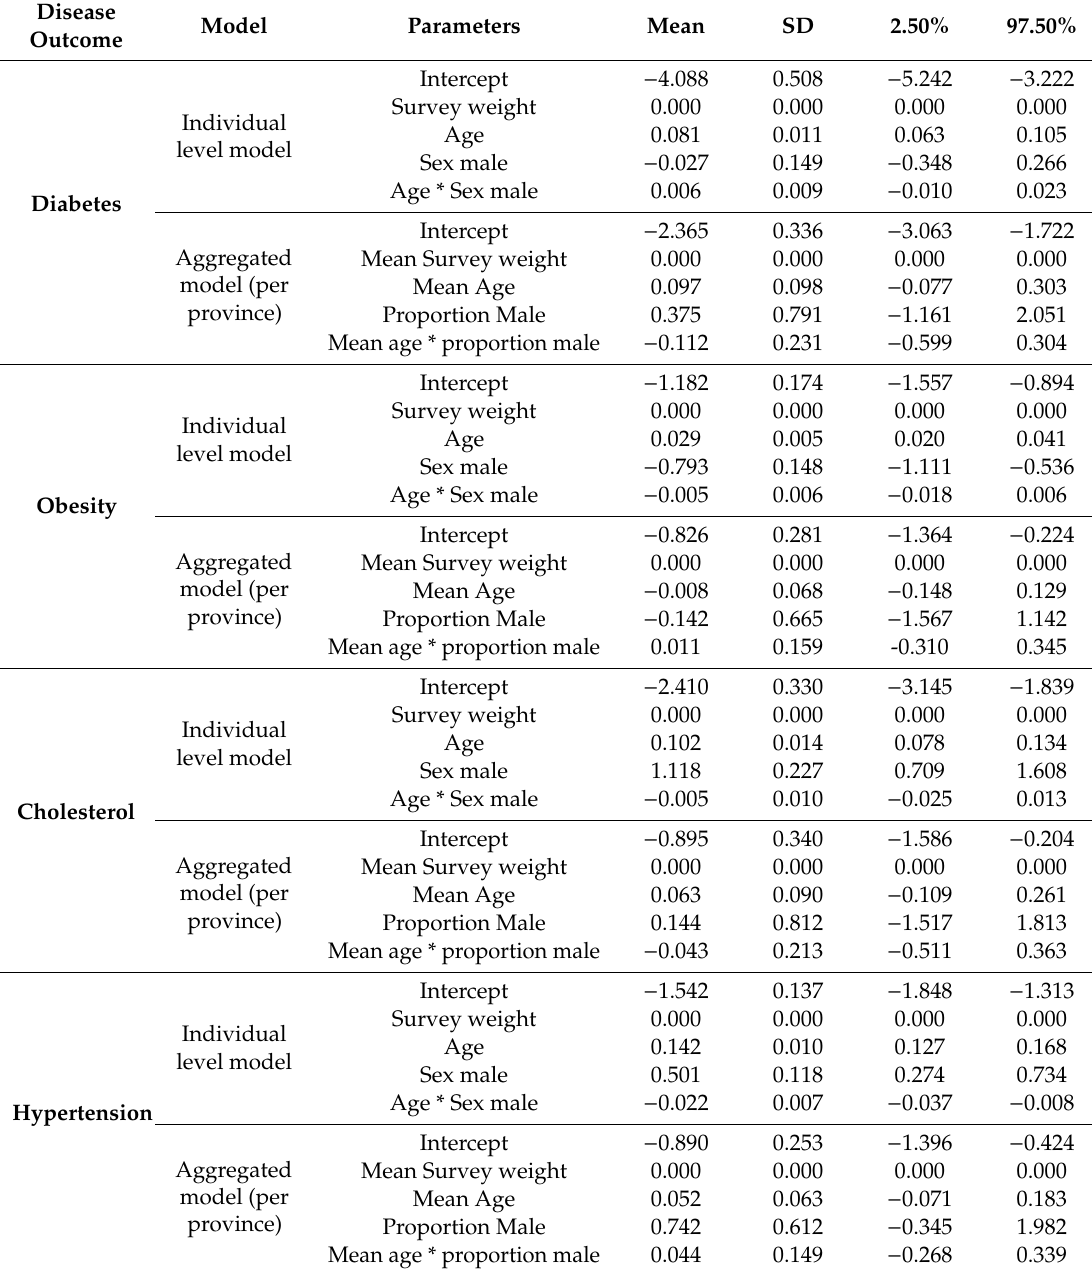
Table 2. Posterior mean estimates for regression parameters in the joint model for diabetes, obesity, cholesterol (elevated LDL), and hypertension for both individual and aggregate level